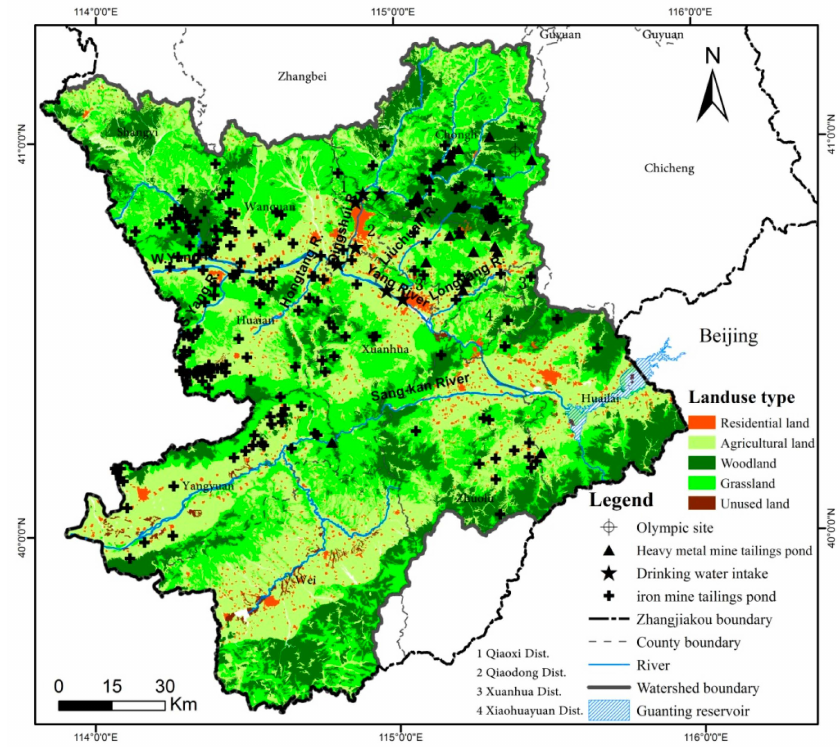
Figure 2. Guangting Reservoir watershed within